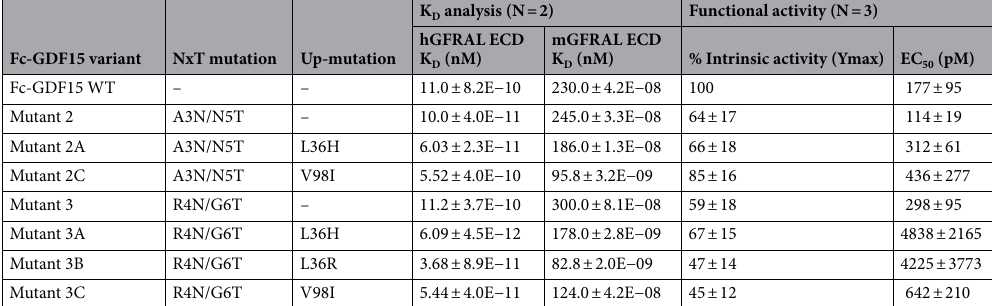
Table 1. Screening up-mutants for GFRAL binding affinity and p-ERK signaling activity. Table summarizing in vitro characteristics of Fc-GDF15 up-mutants compared to a wildtype (WT) Fc-GDF15 control. Binding affinity (K D ) was measured for recombinant human and mouse GFRAL extra-cellular domain (ECD) using surface plasmon resonance (N = 2). Functional activity was measured using p-ERK HTRF assay and reported as EC 50 and % intrinsic activity (Ymax) normalized to Fc-GDF15 WT (N = 3). Data are shown as mean ±